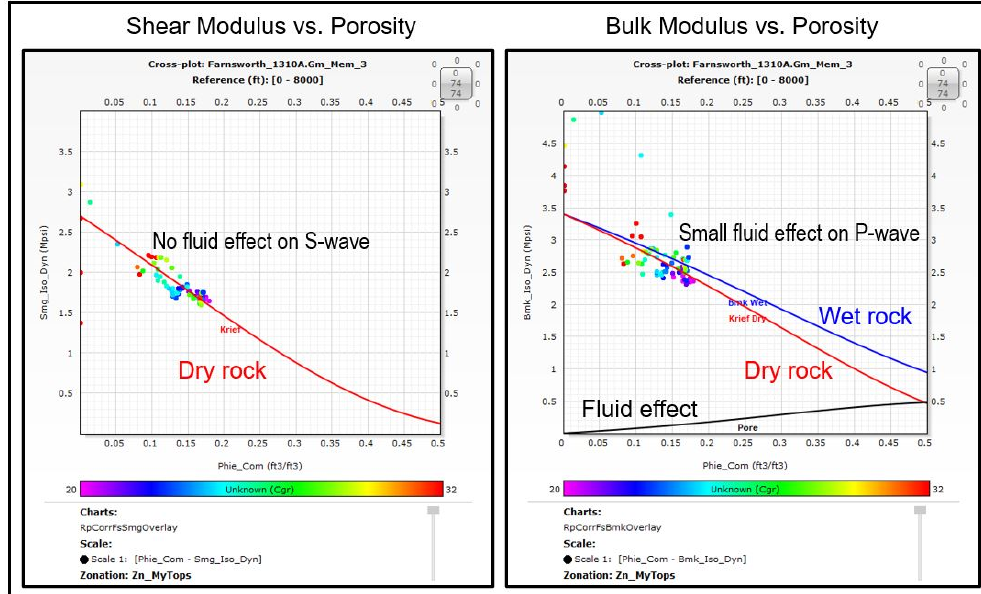
Figure 6. Morrow B geophysical log based evaluation of shear ( left ) and bulk ( right ) moduli showing Krief model fit for determination of K s , G s (y-intercept) and K d , G d vs. porosity relationships. Shear and compressional seismic velocities were computed as;